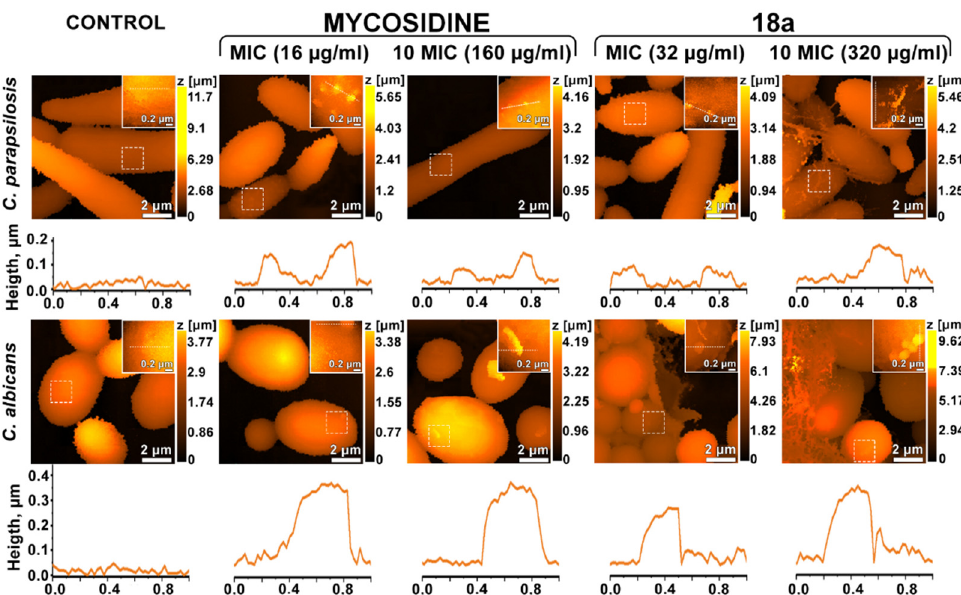
Figure 6. SICM images of topography of Candida cells ( C. parapsilosis and C. albicans ) before and after treatment with Mycosidine and 17b at MIC and 10×MIC.